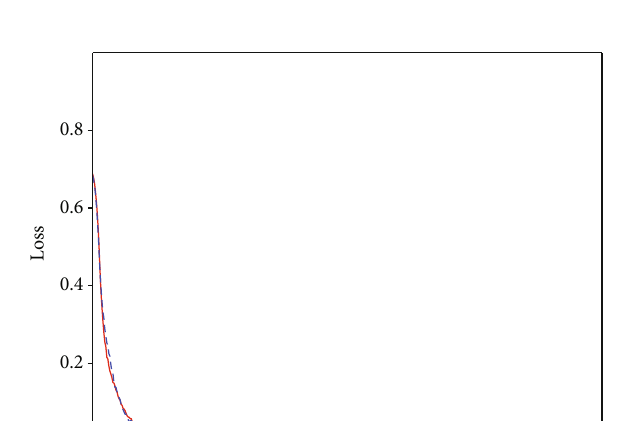
Figure 12: Accuracy curve.